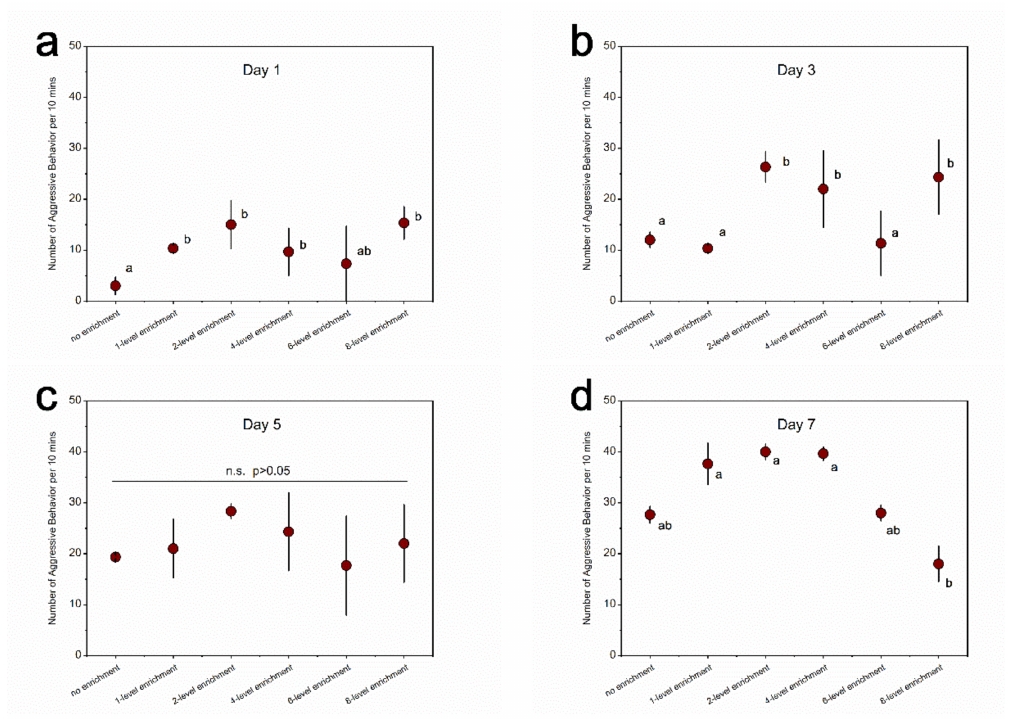
Figure 4. Levels of aggressive behavior in fat greenling among treatments within a specific experimental day. ( a ) Day 1; ( b ) day 3; ( c ) day 5; ( d ) day 7. Different letters indicate significant differences among treatments within a specific experimental day. n.s. indicates no significant difference. n = 3. Data are presented as means ±